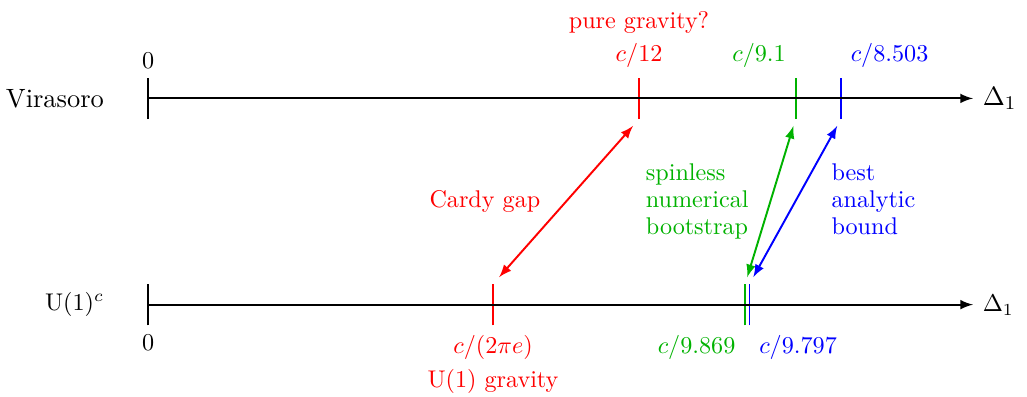
Figure 7 . Spectral gap for the Virasoro algebra and U(1) c algebra at large central charge c . The green and blue marks show upper bounds on ∆ 1 from linear programming, i.e., the modular bootstrap. The numerical upper bounds were estimated for Virasoro in [80] and for U(1) c in [50]. The analytic result for U(1) c is the Kabatyanskii-Levenshtein bound [81, 82], and the analytic bound for Virasoro was derived in